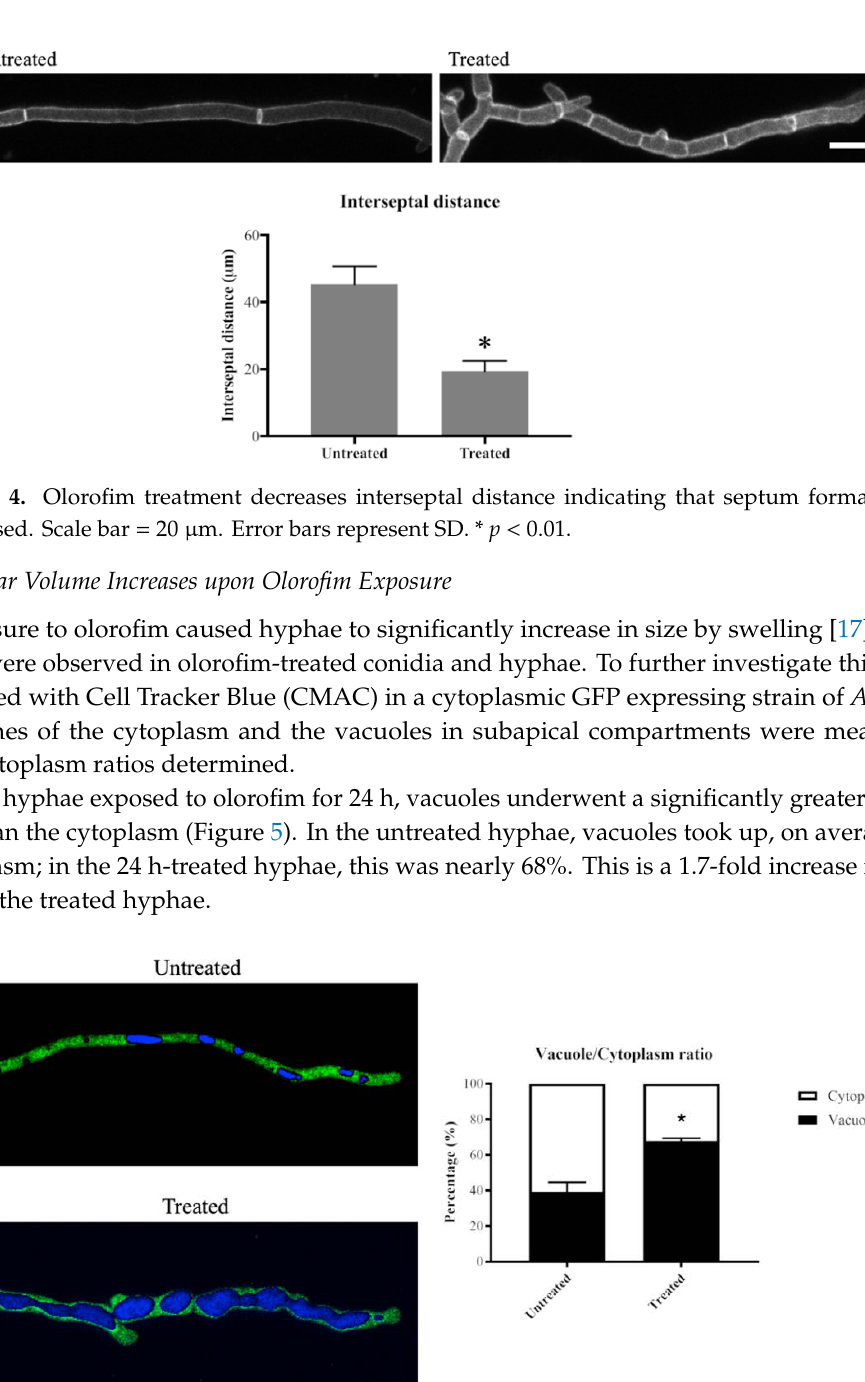
Figure 5. Vacuolar volume increases in 24 h olorofim-treated hyphae. Vacuoles in a cytoplasmic-GFP strain were stained with CMAC and the vacuole/cytoplasm ratio was measured. Vacuolar volume was significantly enlarged after exposure to olorofim, resulting in a reduced cytoplasmic volume. Scale bar = 10 µm. Error bars represent SD. * p < 0.01.